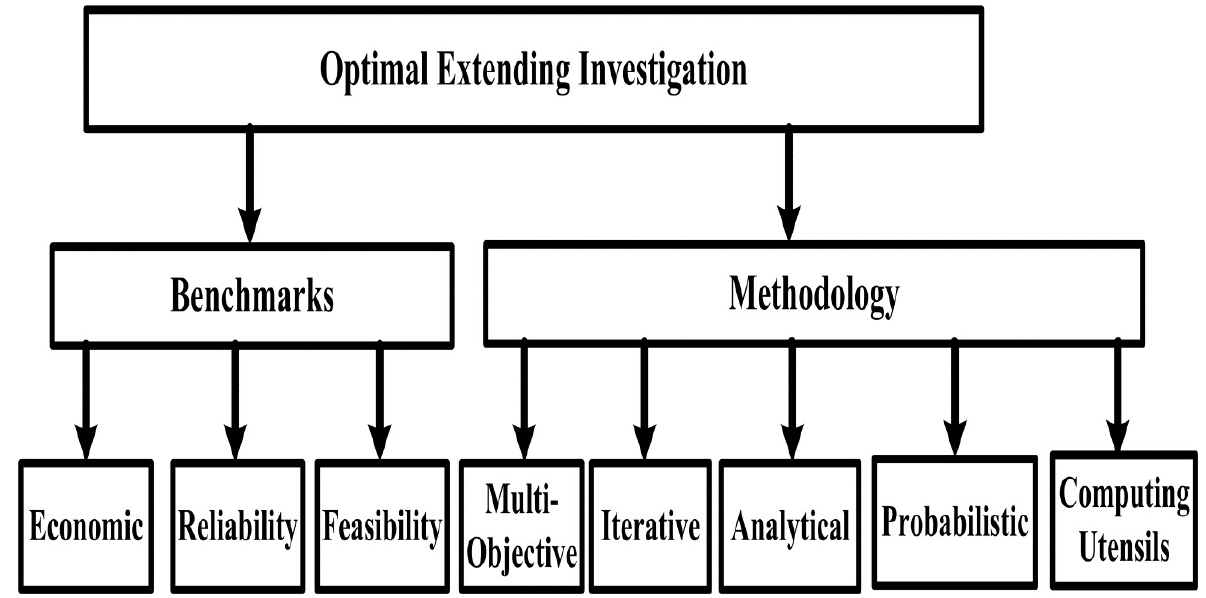
Figure 3. The methodological approach of typical IHMS